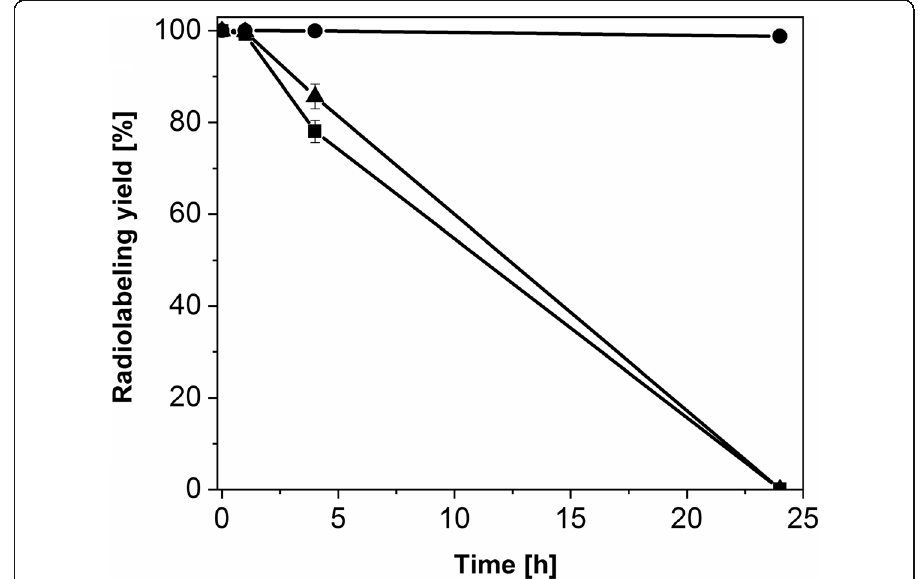
Fig. 6 Stability of the radiopeptide over time, in the presence and absence of ascorbic acid: the graph shows the % intact 161 Tb/ 177 Lu-DOTATOC over a period of 24 h. In the presence of ascorbic acid 177 Lu and 161 Tb-DOTATOC curves overlap, making it impossible to visualize both